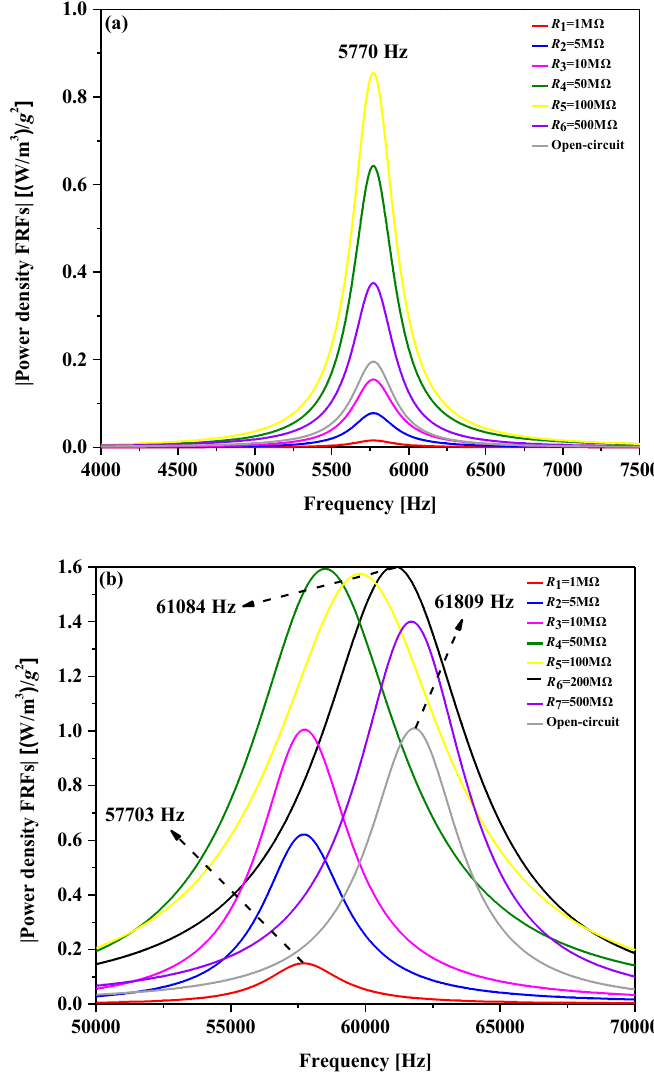
Figure 7. Power density FRFs of the beam for the first order mode for ( a ) h = 3 µ m thickness; ( b ) h = 0.3 µ m thickness beams.